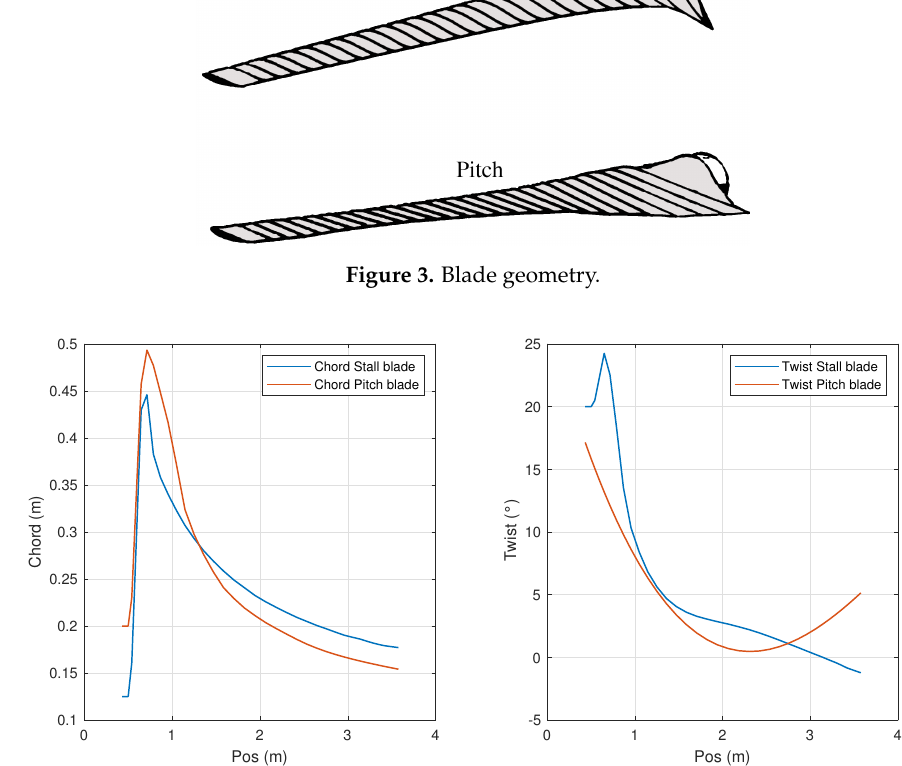
Figure 4. Chord and twist functions for the stall and pitching